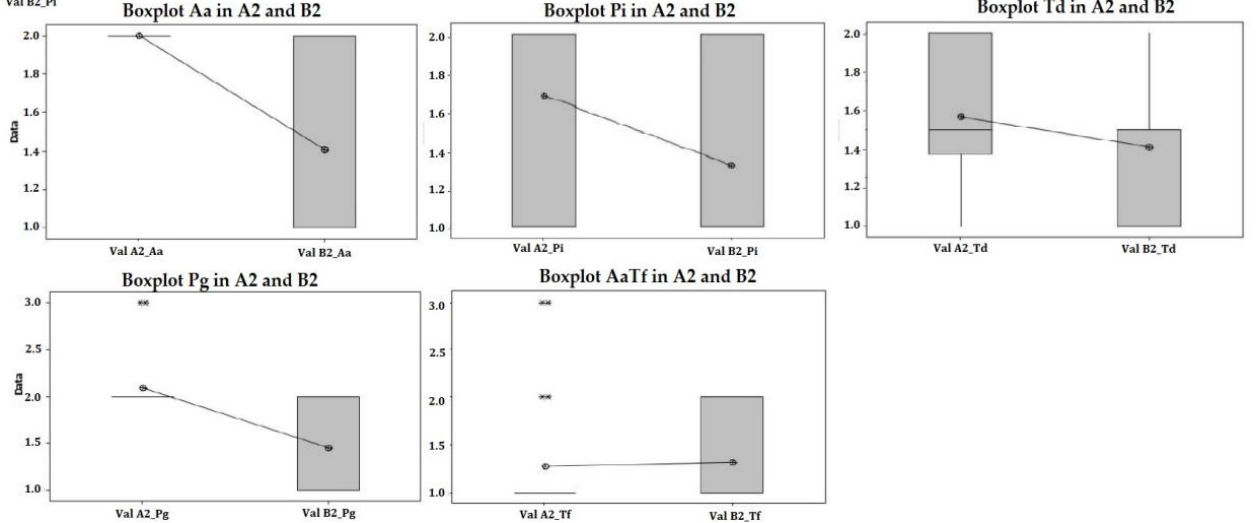
Figure 10. The Box plots show: A. Actinomycetemcomitans , P. Gingivalis- show statistically significant differences between groups; meanwhile, P. Intermedia, T. Denticola and T. Forsythia seem to show no significant difference between treatments.The median is the dot in the middle of the ‘box’. The upper side of the box is the 1st quartile or 25% of the data, from the rest. The lower side of the box is the 3rd quartile,or 75% of the data, from the rest. The distance between the sides of the box is called the inter-quartile range (IQR). The distance between these is called the range.